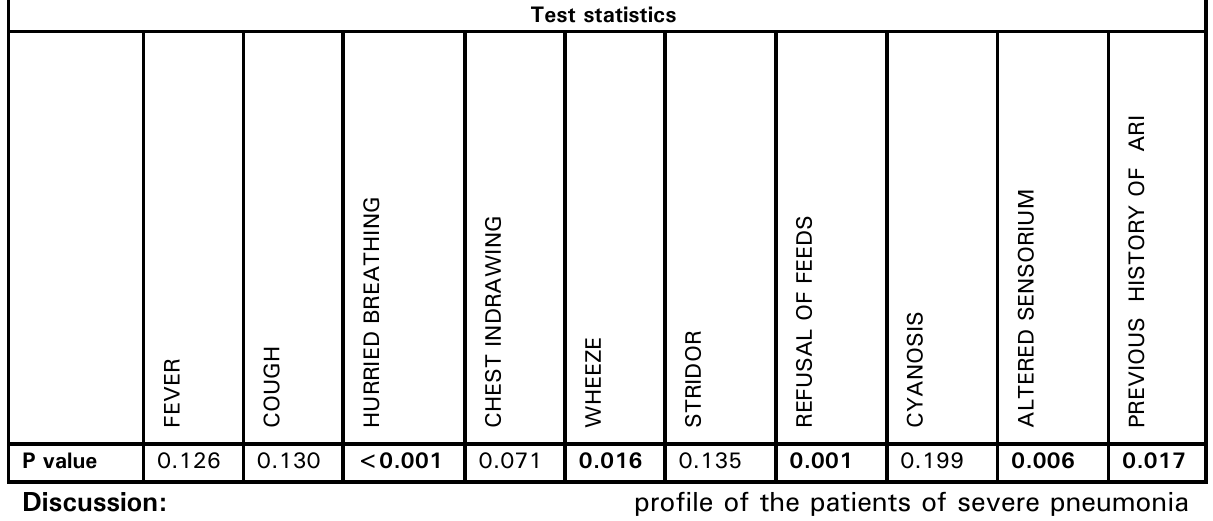
Table 2: Association of the history and symptoms with radiological Abnormalities Test